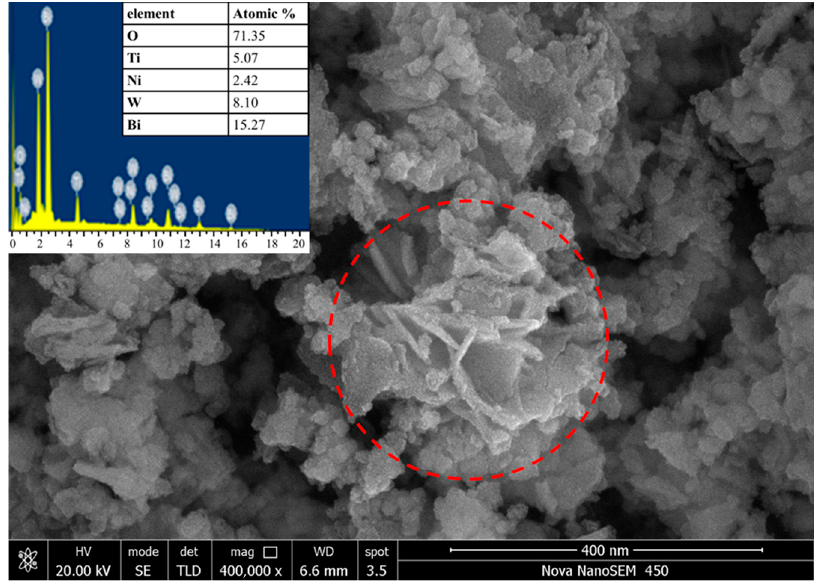
Figure 2. SEM images of Ni/Ti (0.4)-Bi 2 WO 6 and EDX of 0.4Ni/Ti -Bi 2 WO 6 .